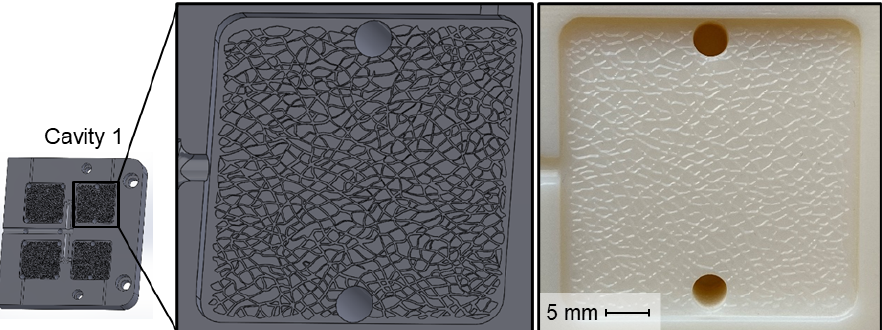
Figure 3. Comparison between designed and printed cavity 1.